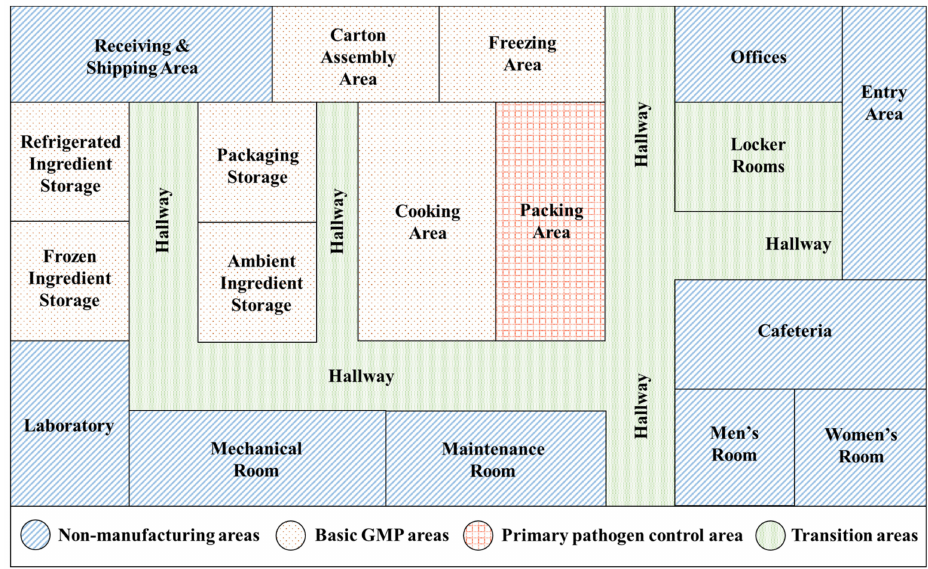
Figure 2. Example of hygienic zone mapping in a hypothetical ready-to-eat food facility, demonstrat- ing different hygienic zones based on the potential risk of contamination by L. monocytogenes